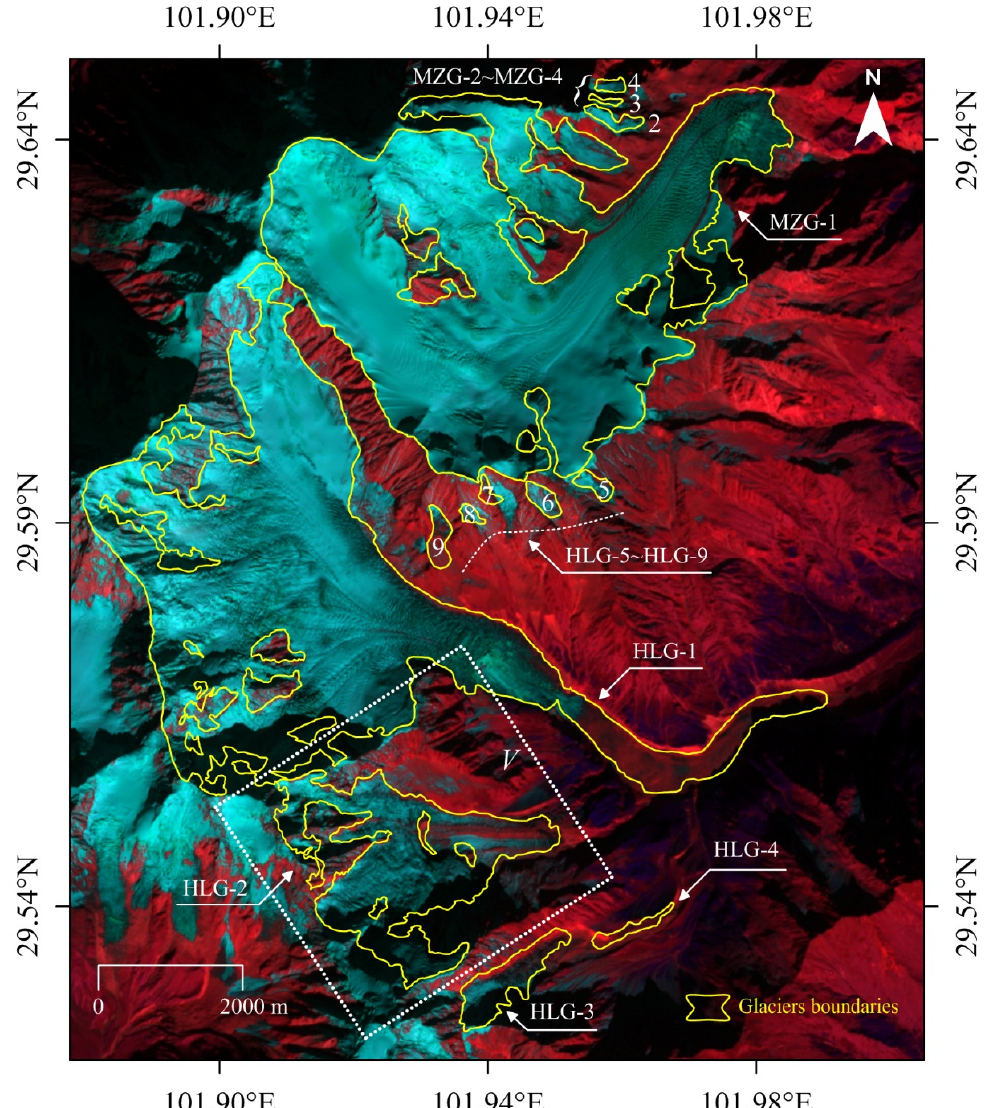
Figure 7. Glacier boundaries derived from the ACR map by manual digitizing (the yellow solid polygons). The background is a composite false-color map using Sentinel-2 satellite bands 12, 3, and 4 (red, green, and blue) acquired on 6 November 2017. The white dashed rectangle corresponds to the accuracy verification area in Figure 8.